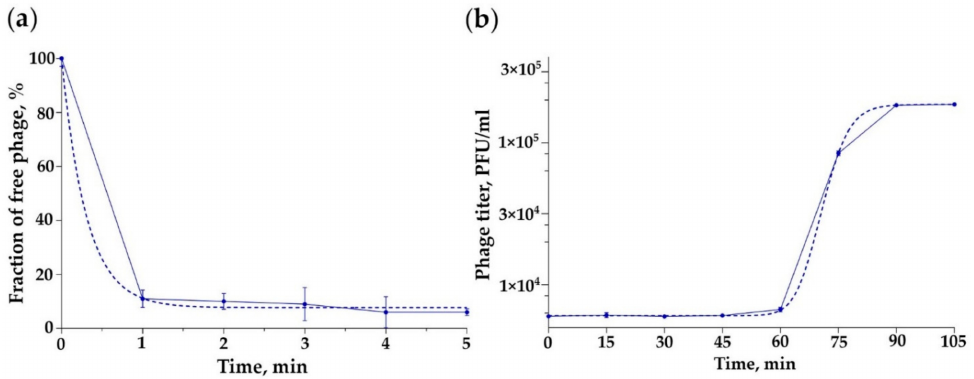
Figure 4. Phage infection parameters. ( a ) Adsorption and ( b ) one-step growth curve of Enterococcus phage iF6. The graphs were created with GraphPad Prism 8.4.3. Error bars represent the standard deviation for average values from three independent trials. The dotted line marks the interpolation according to ( a ) the exponential model and ( b ) the sigmoid